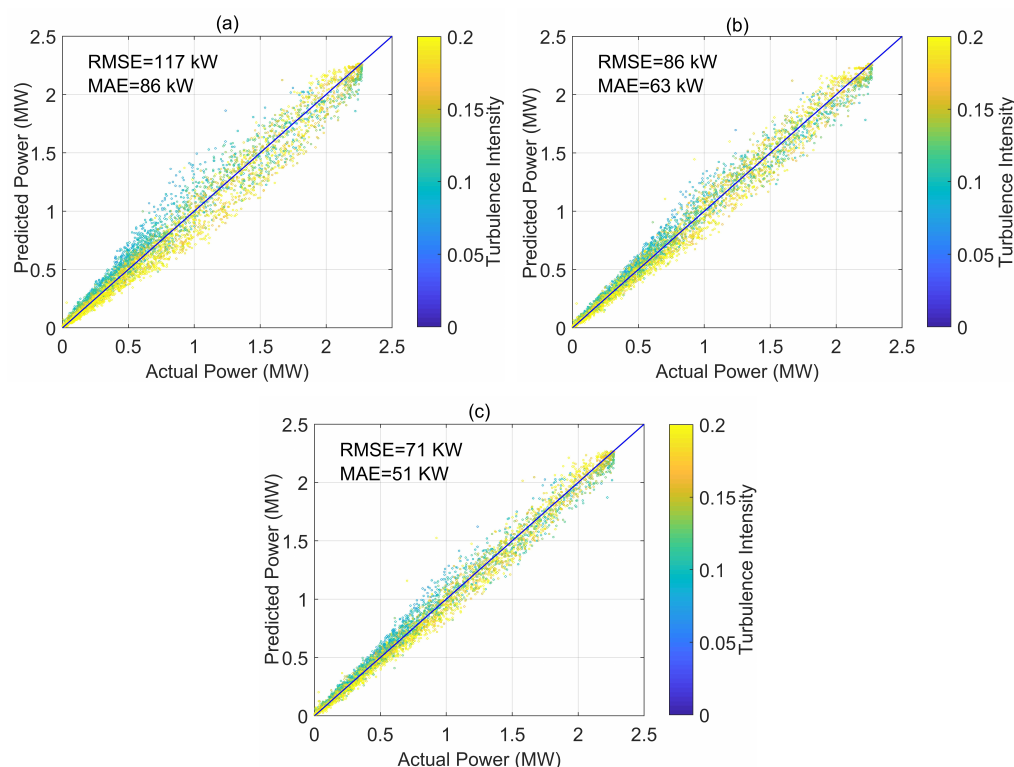
Figure 15. Performance of: ( a ) standard power curve with ( ρ 0 = 1.19 kg · m − 3 ); ( b ) ten-minute modified power curve with ( ρ 0 = 1.19 kg · m − 3 ); and ( c ) power